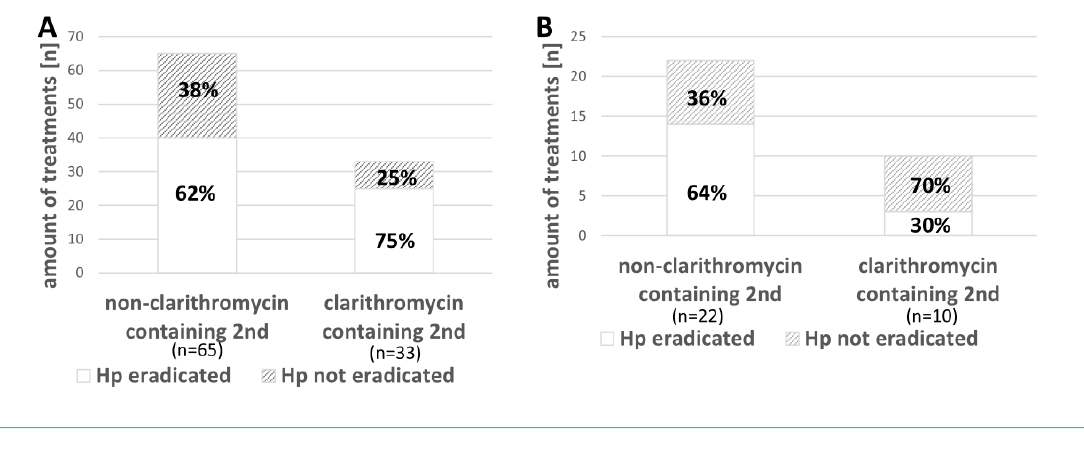
Figure S1: Second-line Helicobacter pylori eradication therapies and their success (between the years 2004 and 2018). A : Different second- line therapies and their successfulness after failed non-clarithromycin containing first-line therapies. B : Different second-line therapies and their successfulness after failed first-line clarithromycin containing therapies. Hp: Helicobacter